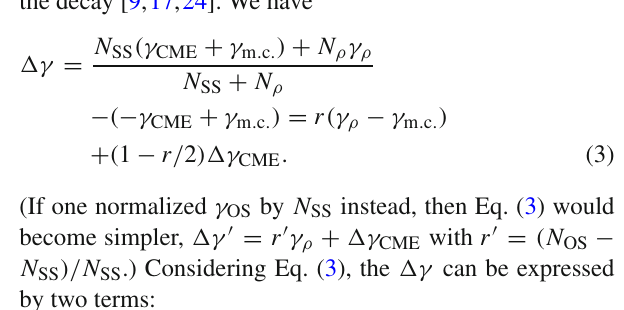
2 GeV / c 2 ) = ( 4 . 5 ± 0 . 8 ) × 10 − 5 is consistent with the